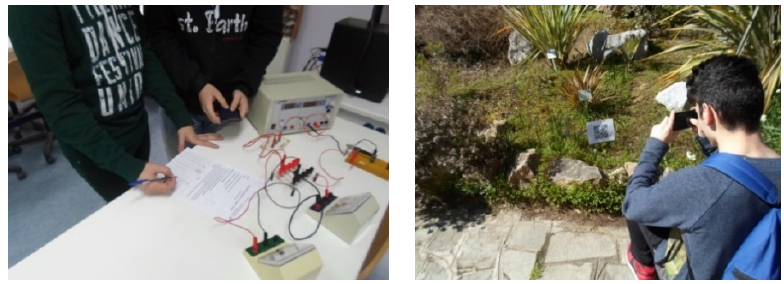
Figure 7. Students participating in the formative assessment activities.